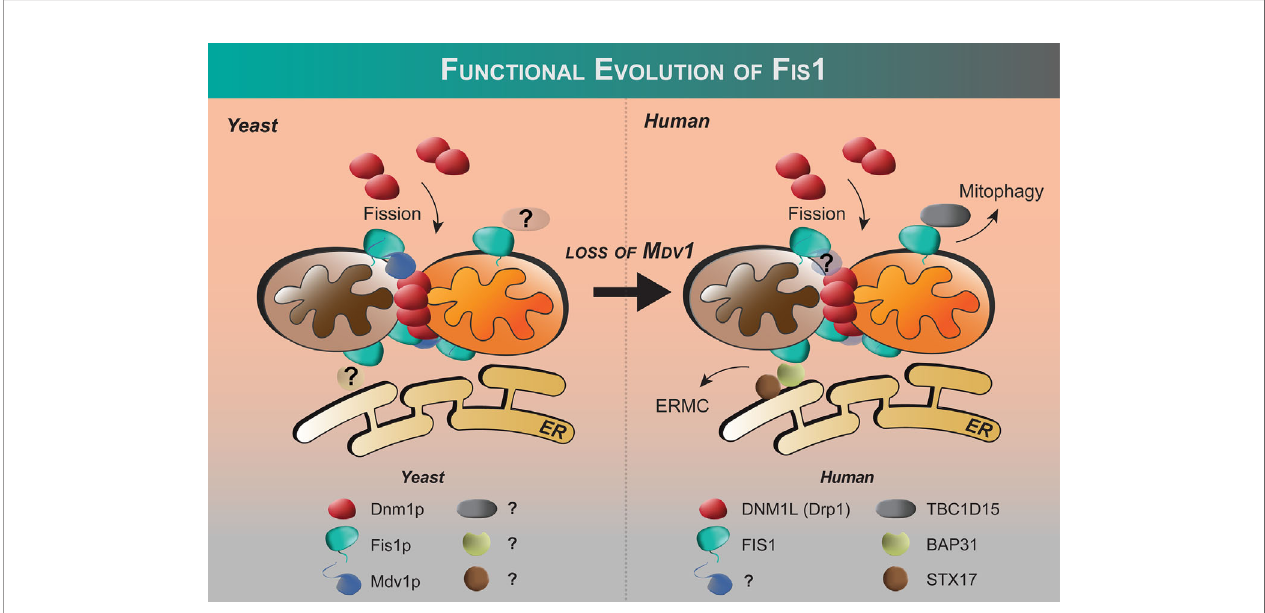
FIGURE 2 | Functional evolution of Fis1 from yeast to humans. Fis1 interacting partners appear to differ between fungi and higher eukaryotes. In budding yeast, the fi ssion mechanoenzyme Dnm1p is recruited to mitochondria by resident mitochondrial protein Fis1p with Mdv1p acting as an adapter. In yeast, Fis1p appears to play an early and late role in Dnm1p assembly (86). No human ortholog of Mdv1p has been identi fi ed to date, and human Fis1 is thought to recruit proteins other than the fi ssion mechanoenzyme Drp1 to the mitochondrion (see text). The extent of the Fis1 interactome is not fully de fi